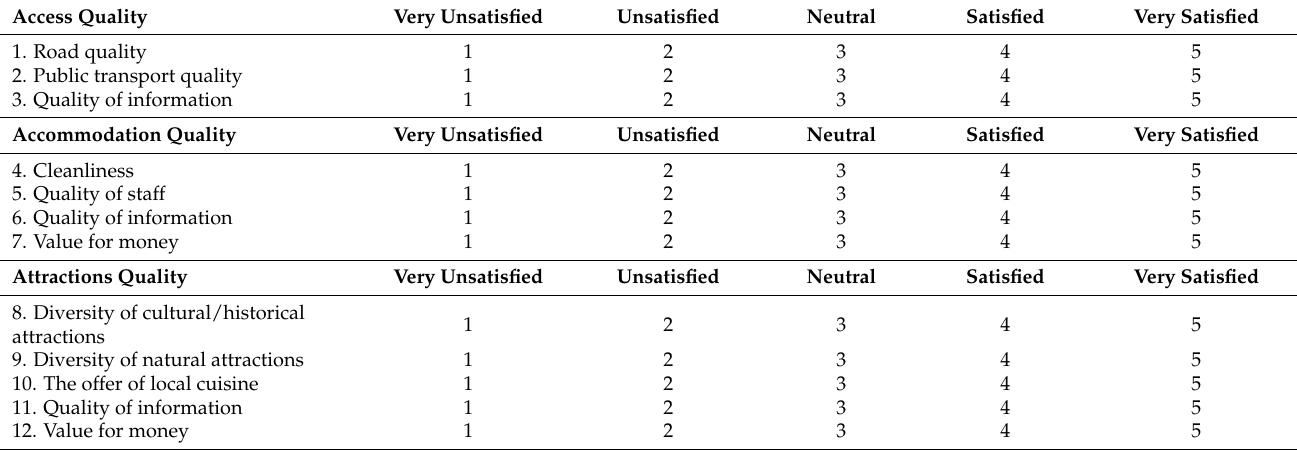
Table A4. Items for quality of tourist services.